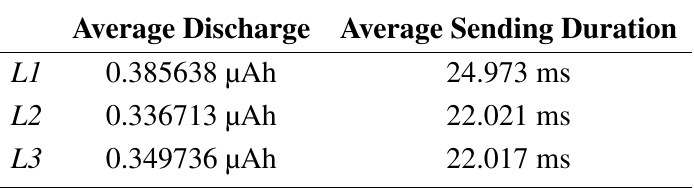
Table 2. Energy statistics L1–L3 for measurement 2.